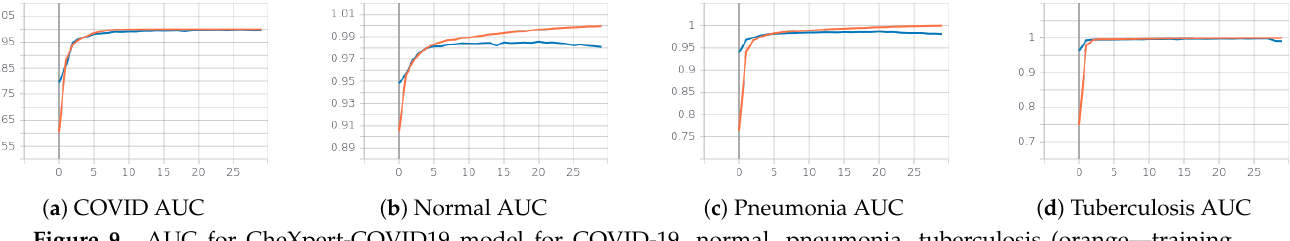
Figure 9. AUC for CheXpert-COVID19 model for COVID-19, normal, pneumonia, tuberculosis (orange—training, blue—validation).